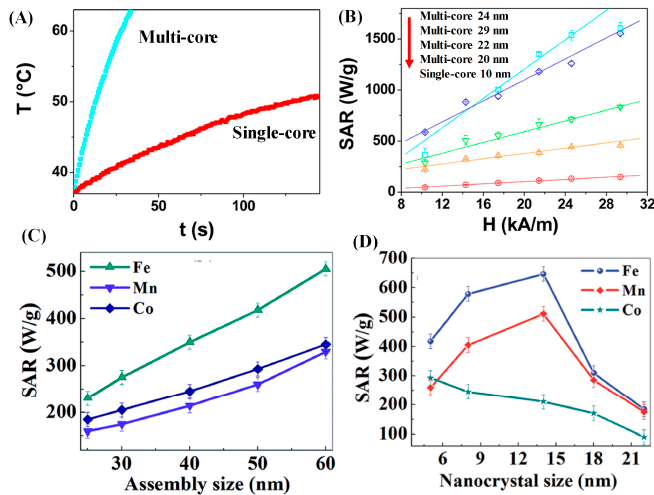
Figure 16. A comprehensive demonstration of the optimization of hyperthermia heating efficiency of MFe 2 O 4 MNPAs by controlling size, composition, and magnetic coupling among the nanocrystals within the nanoassembly. ( A ) Heating curves for multi-core and single-core Fe 3 O 4 nanostructures are recorded under an ACMF of amplitude 29 kA/m and at frequency 520 kHz [25]. ( B ) SAR values as a function of the ACMF amplitude at frequency f = 520 kHz for multi-core 24 nm (cyan), multi-core 29 nm (blue), multi-core 22 nm (green), multi-core 20 nm (orange), and single-core 10 nm (red) [25]. ( C ) The SAR as a function of nanoassembly size of MFe 2 O 4 (M = Mn, Fe and Co) with nanocrystal size 4 nm [70]. ( D ) The SAR as a function of nanoassembly size of MFe 2 O 4 with variation of nanocrystal size from 6 to 21 nm [70].